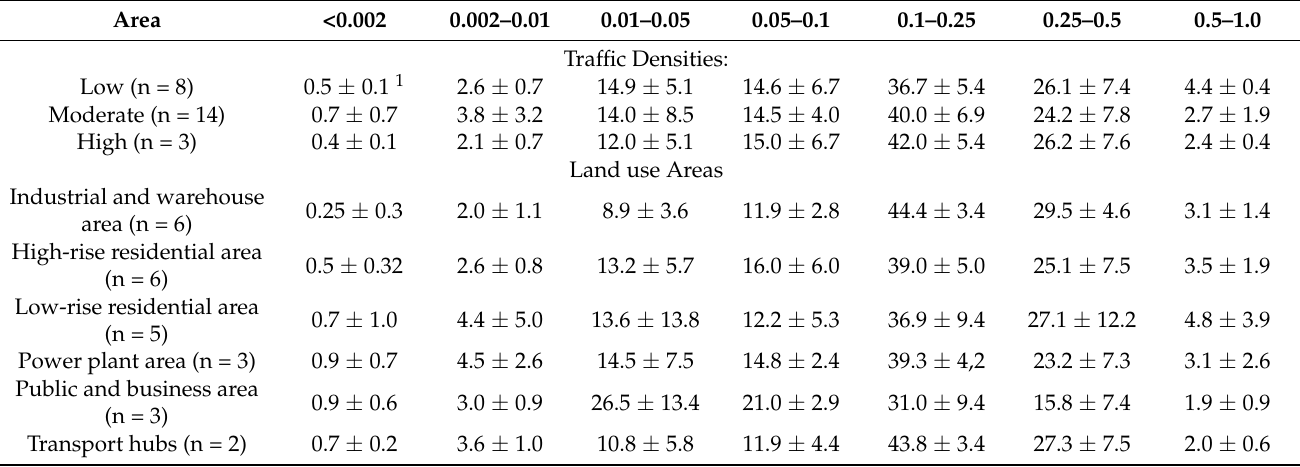
Table 2. The percentage of particle size fractions (mm) in road dust depending on (a) traffic densities and (b) land use within Surgut city.